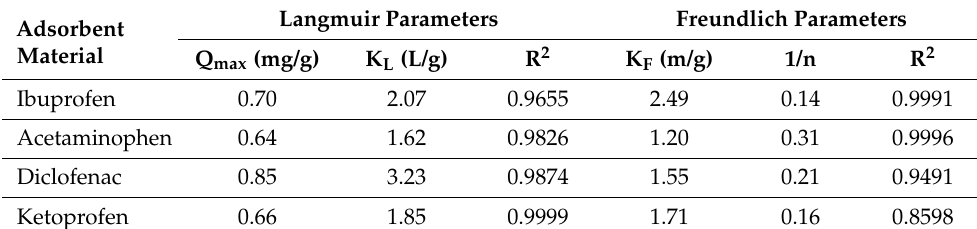
Table 9. Langmuir and Freundlich adsorption parameters.